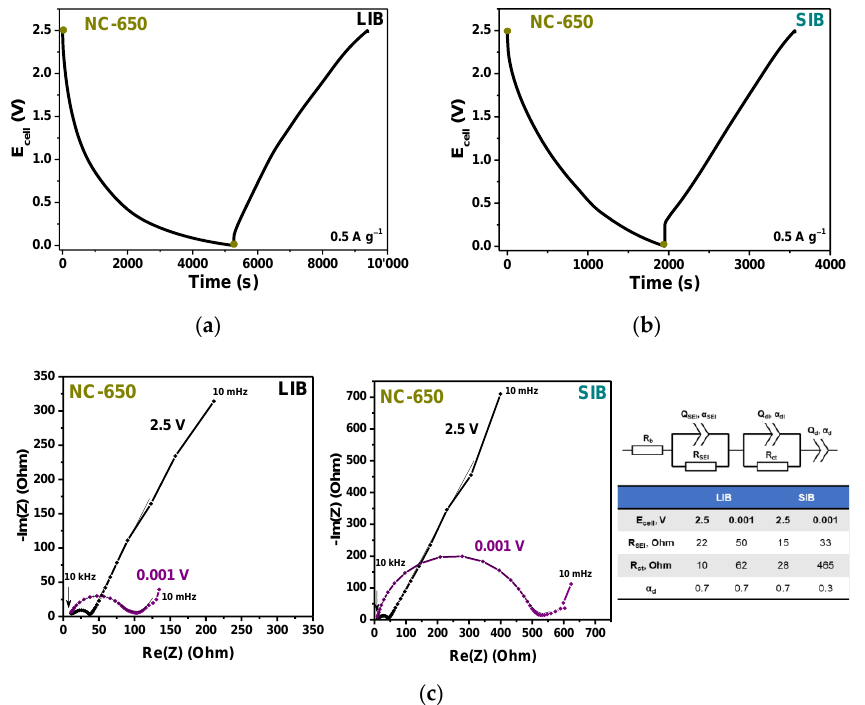
Figure 8. Galvanostatic charge – discharge profiles of the NC-650 electrode at a constant current density of 0.5 A·g ‒1 in ( a ) LIB and ( b ) SIB. ( c ) Nyquist plots of EIS spectra for fully charged (at a potential of 2.5 V) and fully discharged (at a potential of 0.001 V) LIB and SIB cells with the NC-650 electrode with the simulation equivalent curves and the equivalent circuit with fitted parameters.